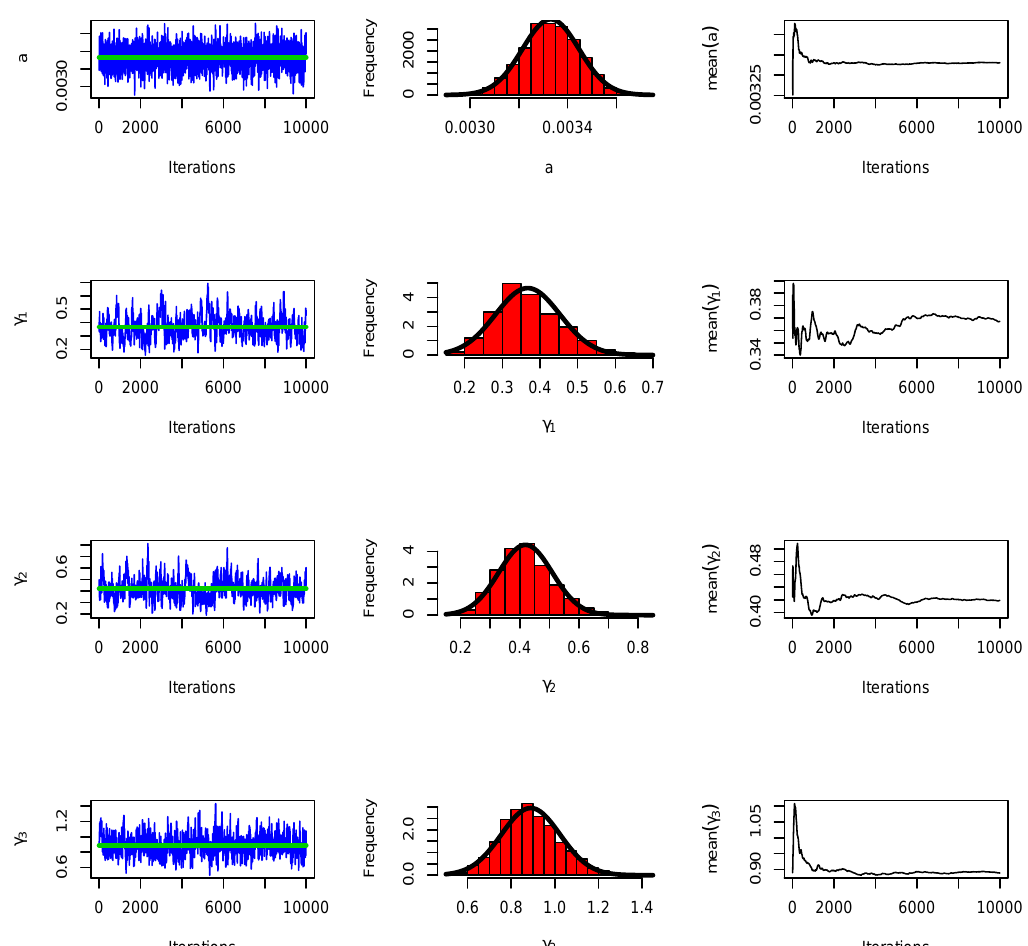
Figure 13. The MCMC plots for data set II using the BBXEx model based on the complete sample. Here, we fit the BBXEx model on data set II based on censored samples. In the